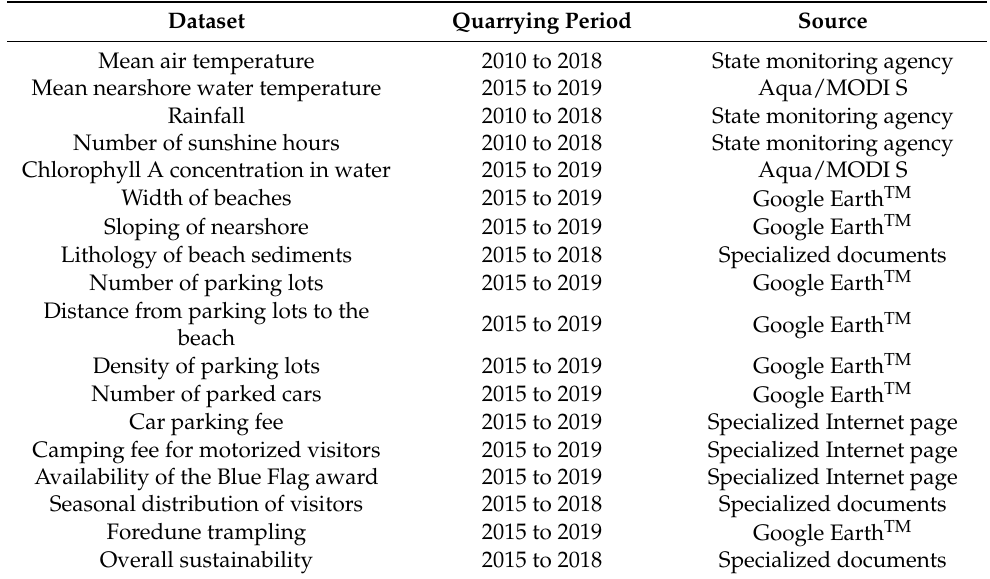
Table 1. Time periods and sources for quarrying datasets for the Delphi-based benchmarking